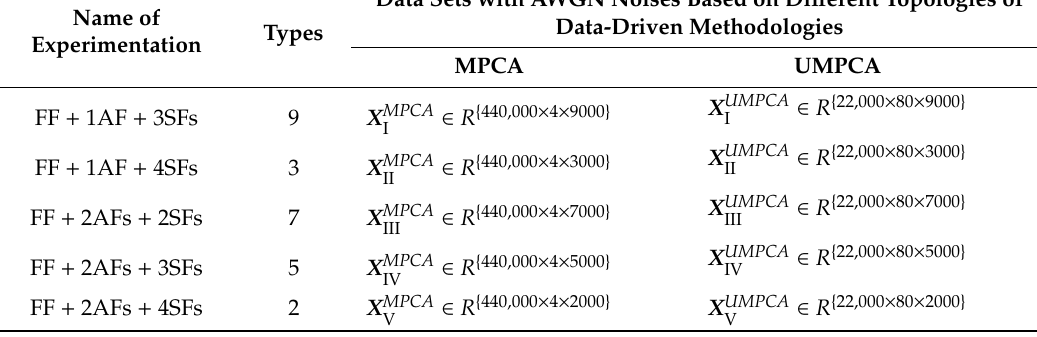
Table 5. Datasets of experimentations with AWGN noises based on di ff erent topologies of the data-driven methodologies: MPCA and UMPCA.